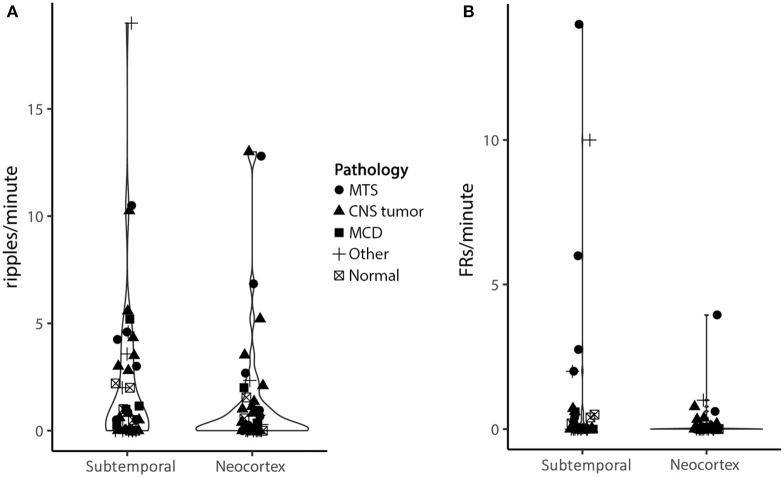
Violin plot of ripple (A) and fast ripple (B) rates in subtemporal and neocortical channels. Each character represents a patient, different characters represent different pathologies. The width of the violin represents the number of dots at a certain y value. Although not significant, there is a trend toward higher HFO rates in the subtemporal compared to the neocortex (ripples: 2.1/min vs. 1.3/min, Z = −1.28, p = 0.20; fast ripples: 0.9/min vs. 0.2/min, Z = −1.74, p = 0.08) (MTS, mesiotemporal sclerosis; CNS, central nervous system; MCD, malformation of cortical development).